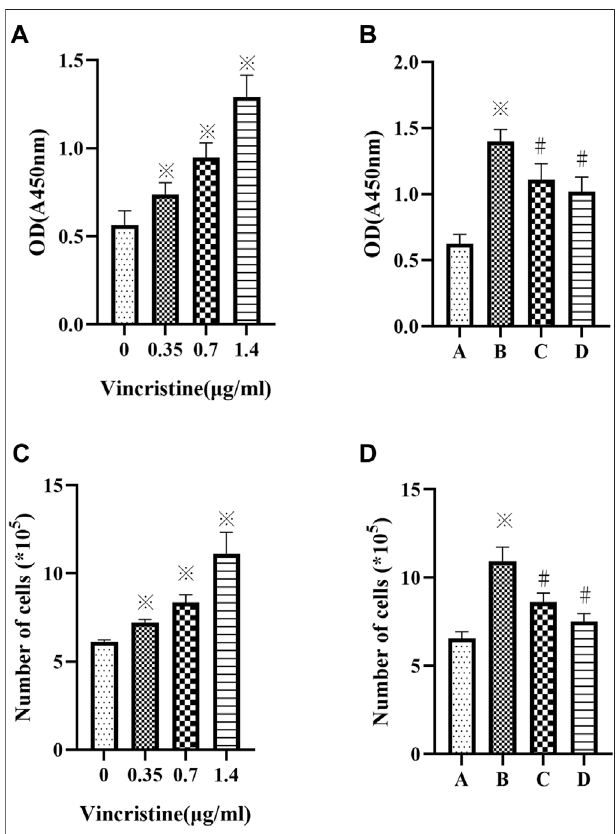
FIGURE 1 |(A,C) : Vincristine (VCR) increases cell proliferation in HELFs. Cells were treated with different concentration of vincristine (0, 0.35, 0.7 and 1.4 μ g/ml) for 24 h * p < 0.05 vs. the control group. (B,D) : VCR-induced cells proliferation wasdecreased by SB203580 and PD98059 in HELFs (cells were treated with 1.4 μ g/ml VCR for 24 h). Cell proliferation was assessed by CCK8 assay. * p < 0.05 vs . the control group; # p < 0.05 vs . the VCR group. A: control group, B: VCR group, C: SB203580 group, D: PD98059